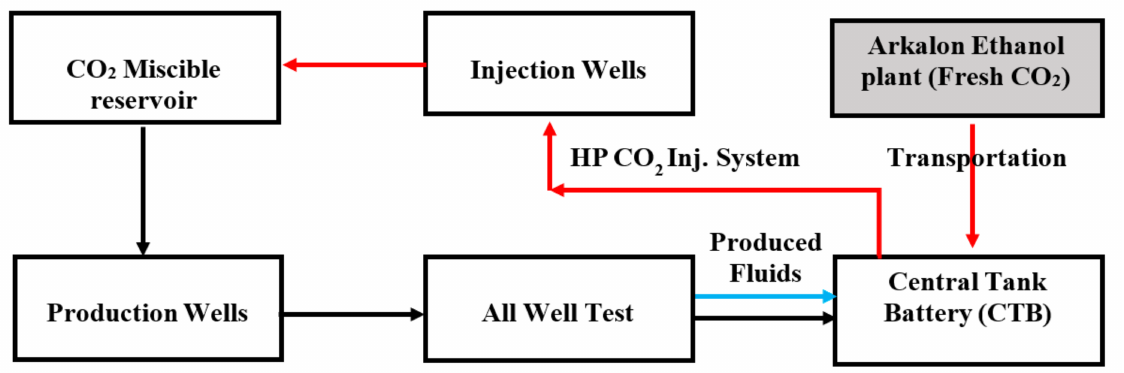
Figure 2. Simplified flow chart representing an overview of the CO 2 -EOR Operations of FWU (Red lines indicate injection fluids, black: produced fluids and blue: gas from